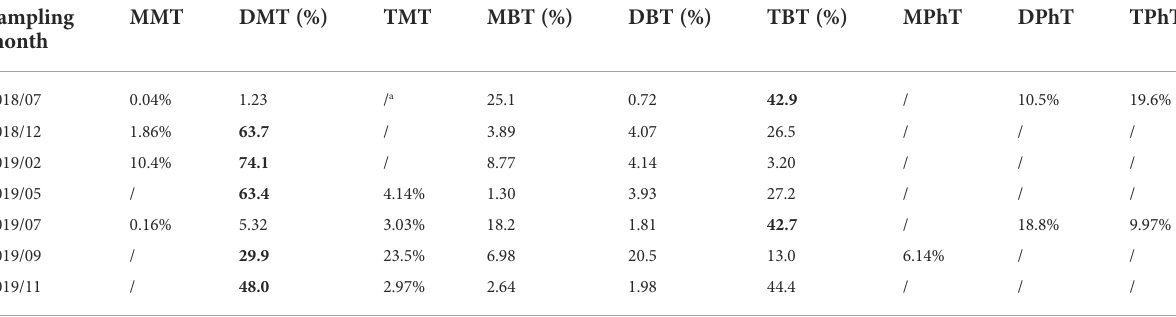
TABLE 2 Composition and proportion of detected organotin compounds (OTCs) in the drinking water source in the upper Yangtze River